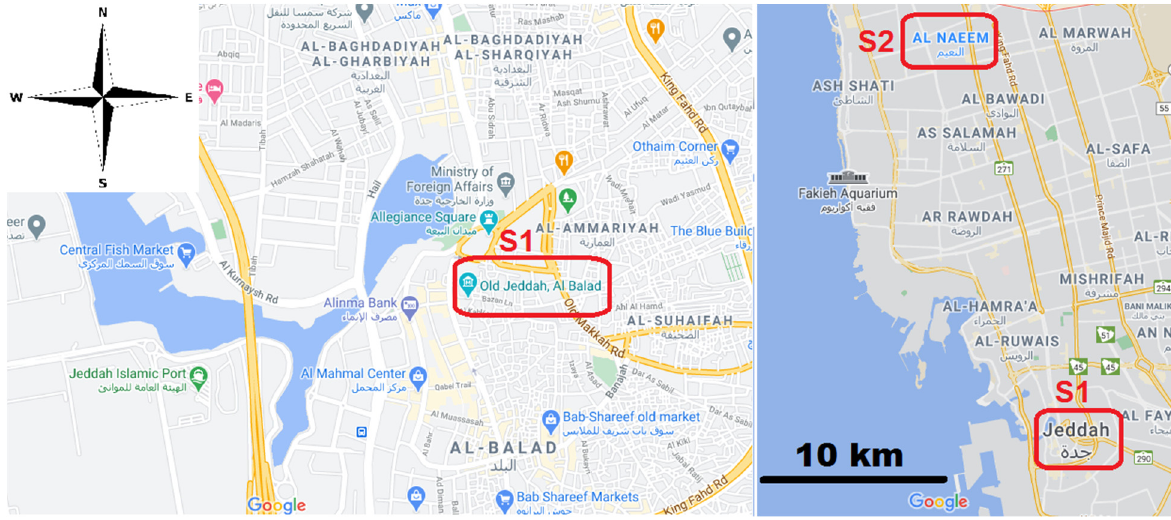
Figure 1. Sampling locations of the PM 2.5 aerosols collected form the historical Jeddah district (S1) and Alnaeem district